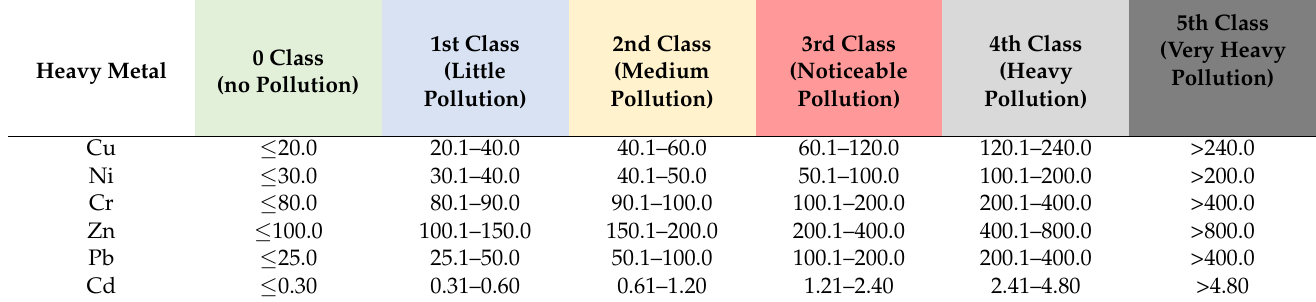
Table 3. Classification of heavy metals in sediments according to the LAWA method (mg/kg).